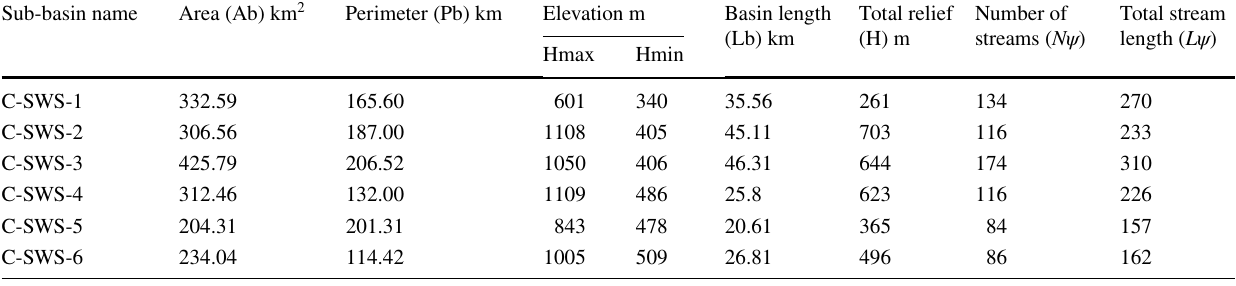
Table 4 Additional morphometric parameters of Champua sub-watershed for Baitarani